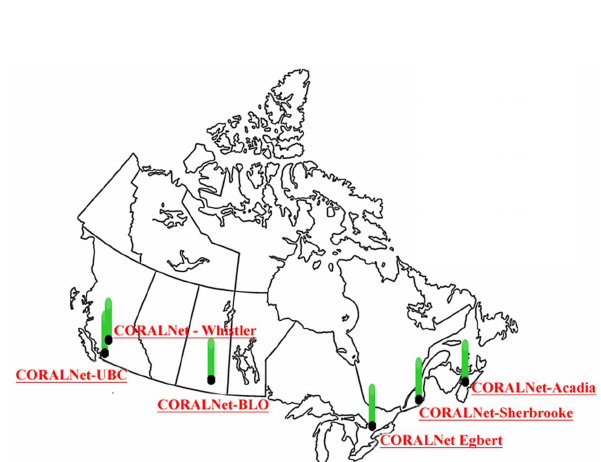
Fig. 4. A map of Canada showing the site locations where the portable, autonomous lidars were deployed. The network is dubbed CORALNet for the Canadian Operational Research Aerosol Lidar